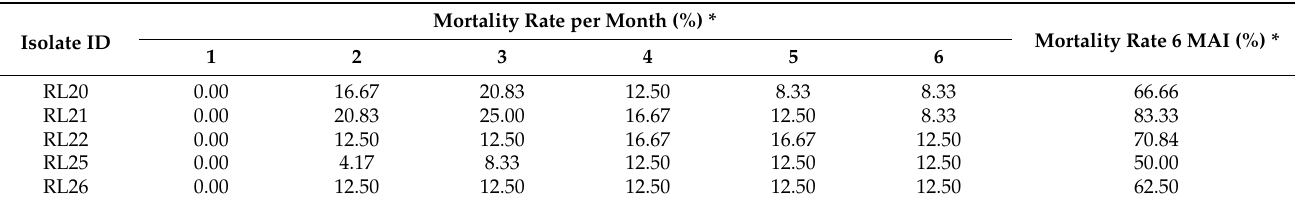
Table 4. Mortality rate of rubber seedling clone RRIM600 inoculated with five different isolates of R. microporus . Mortality Rate per Month (%) * Isolate ID